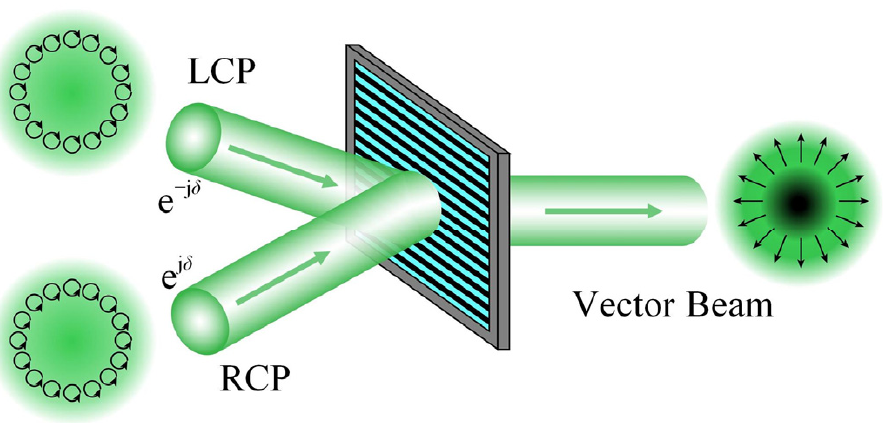
Figure 1. A space-variant linearly polarized beam is generated by the superposition of the left and right circularly polarized beams with inverse phase profiles. The left and right circularly polarized beams overlap each other in the grating, and coaxially combine into the vector beam.